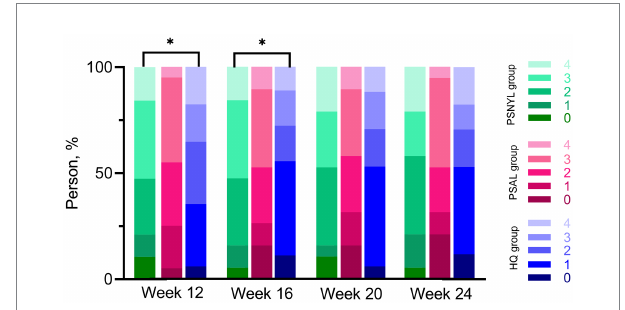
TABLE 5 Adverse or unanticipated events after treatment.